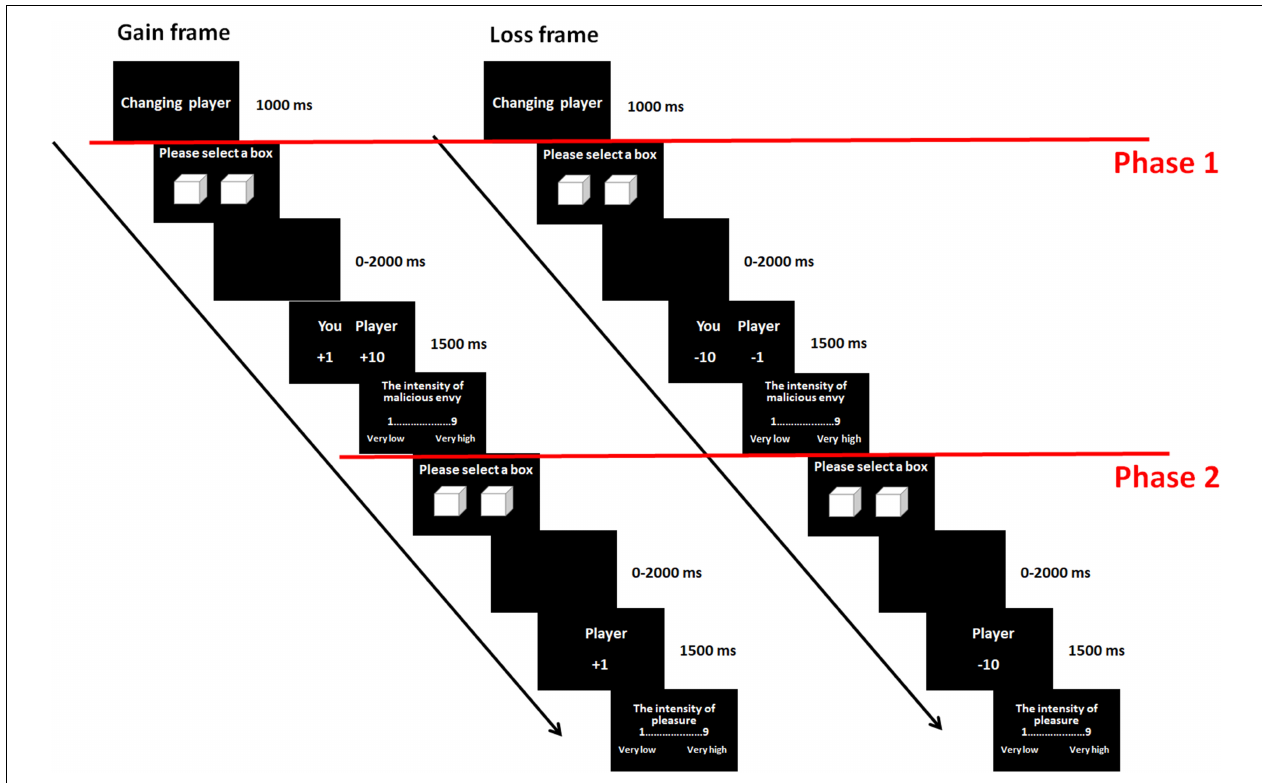
FIGURE 1 | Experimental procedure in gain and loss frames (on left and right panels, respectively).